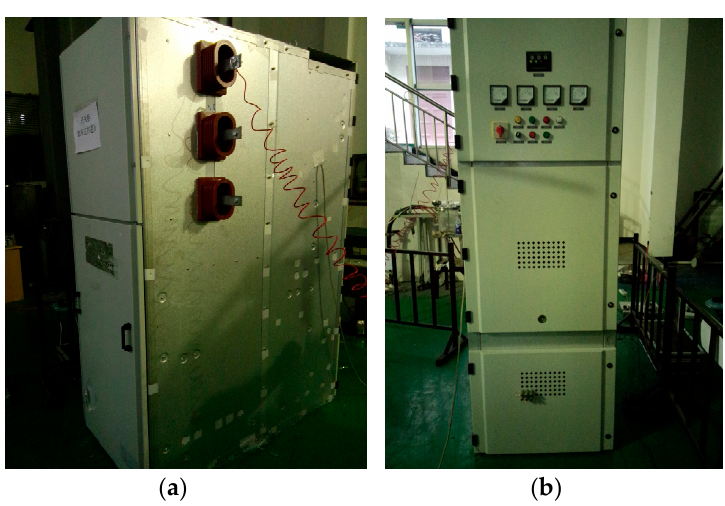
Figure 13. The high-voltage switchgear setup. ( a ) front and ( b ) side view.